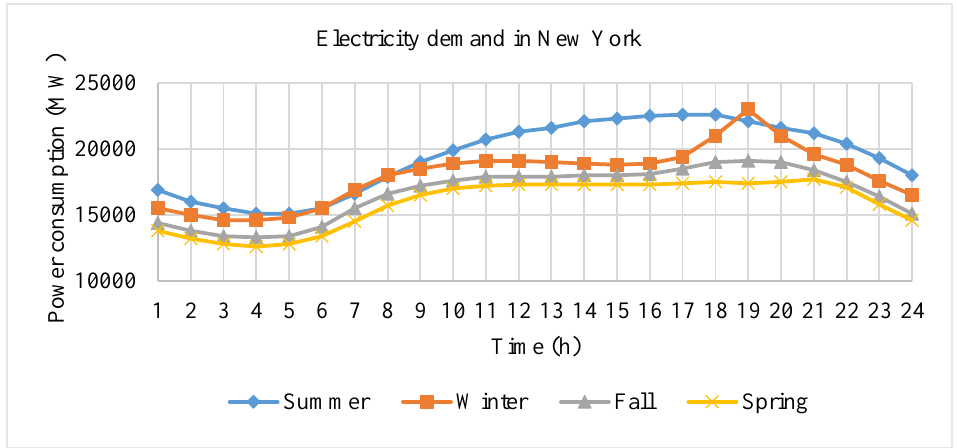
Figure 6. The mean number of charging electric vehicles (EVs).